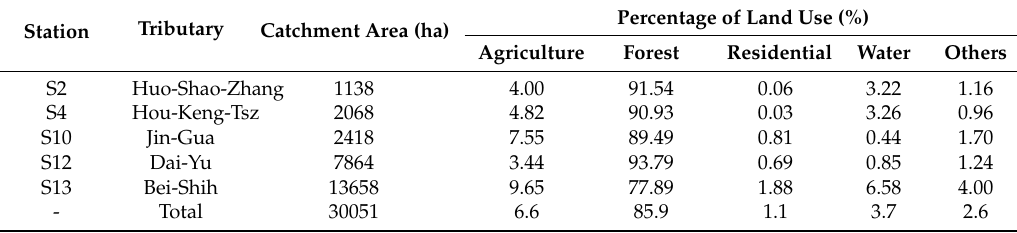
Figure 1. Study area location map of the Fei-Tsui Reservoir catchment in northern Taiwan. Water quality monitoring locations and rainfall stations used in this study are provided. Table 1. Details of land use distribution for each tributary of Fei-Tsui Reservoir.